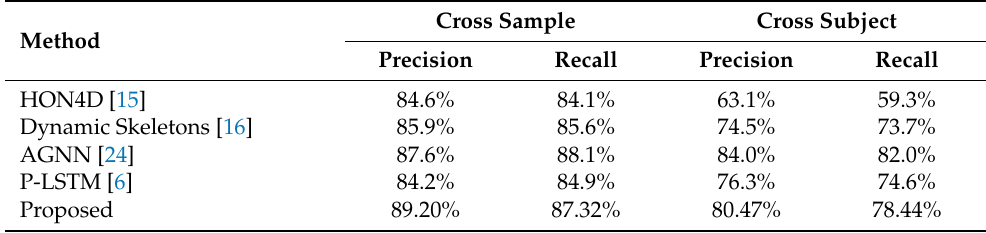
Table 3. Results on large scale combined (LSC)